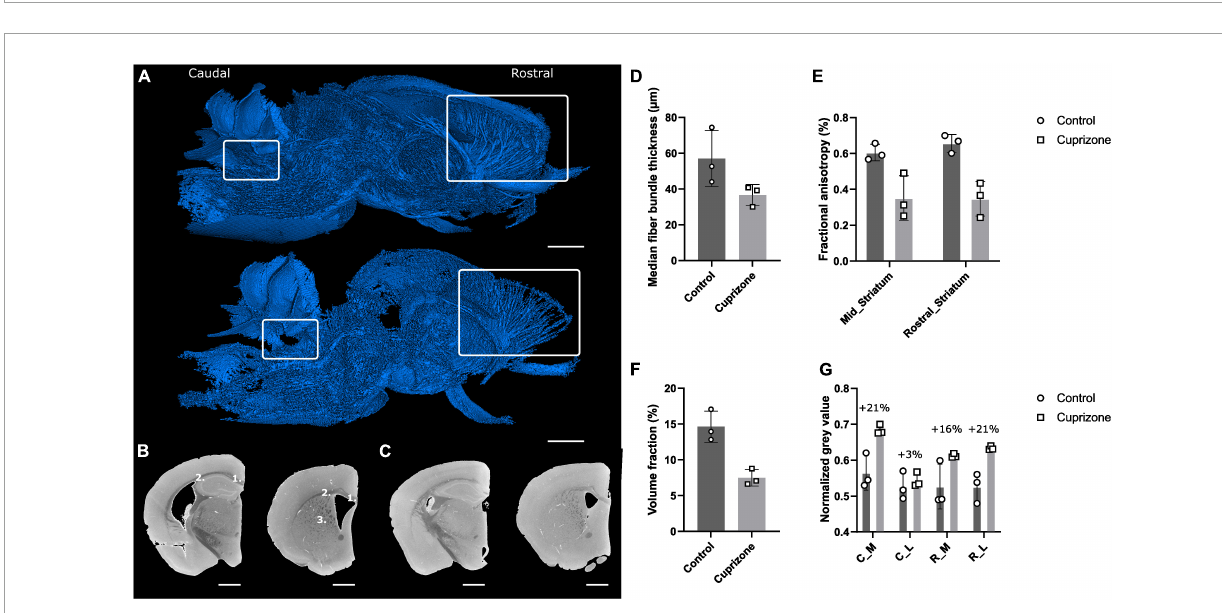
FIGURE7 Effect of cuprizone treatment on myelination using Hexabrix staining and quantitative white matter parameters. (A) 3D rendering of segmented white matter of a cuprizone-treated hemisphere (top) and a healthy hemisphere (bottom). White rectangles indicate regions where demyelination was expected (left: white matter near cerebellar nuclei, right: corpus callosum and corpus striatum). (B) Caudal (left) and rostral (right) coronal gray scale cross-sections of a healthy hemisphere with medial (1) and lateral (2) corpus callosum and corpus striatum (3). Scale bar = 1 mm. (C) Caudal (left) and rostral (right) coronal gray scale cross-sections of a cuprizone-treated hemisphere. Scale bar = 1 mm. (D) Median fiber bundle thickness of healthy and cuprizone-treated hemispheres. (E) Computed fractional anisotropy of healthy and cuprizone-treated hemispheres on the rostral part of the striatum and the middle part of the striatum. (F) Volume fraction of white matter fiber bundles in the striatum. (G) Normalized gray values of healthy and cuprizone-treated corpus callosum. C_M, caudal, medial; C_L, caudal, lateral; R_M, rostral, medial; R_L, rostral, lateral.